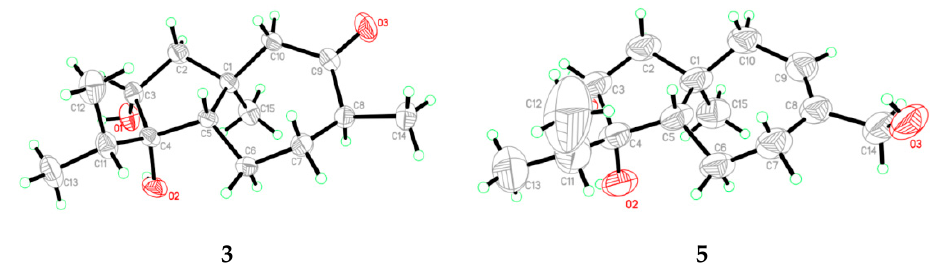
Figure 5. X-ray crystallographic structures of compounds 3 and 5 .